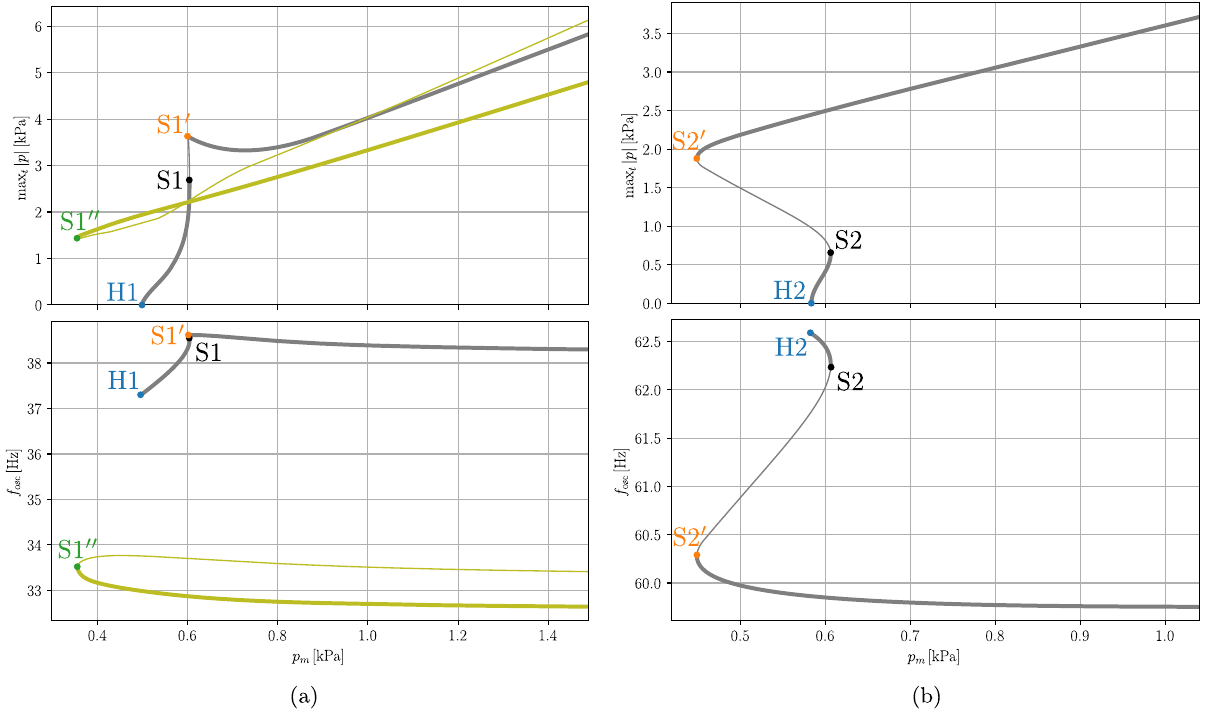
Figure 6. Typical partial bifurcation diagrams for the fi rst Hopf bifurcation and second Hopf bifurcation. Top and bottom plots represent respectively the maximum amplitude of the periodic oscillation branches and their oscillation frequency with respect to the blowing pressure. Left: case of the fi rst Hopf bifurcation, f ‘ ¼ f ‘ ; PN opt ; per = 28.67 Hz; right: case of the second Hopf bifurcation, f ‘ = 51.35 Hz. The line thickness indicates whether the branch portion is stable (thick line) or unstable (thin line). The points H1 and H2 correspond to the Hopf bifurcation points at which a stable oscillation regime arises from the equilibrium for the fi rst and second Hopf bifurcation respectively. S1 and S2 correspond to the saddle-node bifurcation points at which the stable regime arising from the Hopf point destabilises. S1 0 and S2 0 correspond to the saddle-node bifurcation points at which another stable regime appears for the fi rst and second Hopf bifurcation respectively. S1 00 corresponds to the saddle-node bifurcation point at which the stable regime of the pedal note arises from the isolated branch (lime green). (a) First Hopf bifurcation. (b) Second Hopf